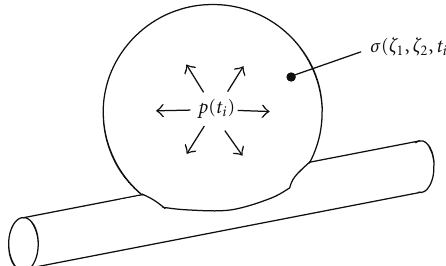
Figure 1: A saccular cerebral aneurysm exposed to an internal pressure p ( t i ) caused by the pulsating blood flow in the parent artery. The internal pressure p ( t i ) causes a stress state in the aneurysm wall, characterised by the Cauchy stress tensor σ ( ζ 1 , ζ 2 , t i ). The surface geometry of the aneurysm is parameterised by the two convected coordinates ζ 1 and ζ 2 .